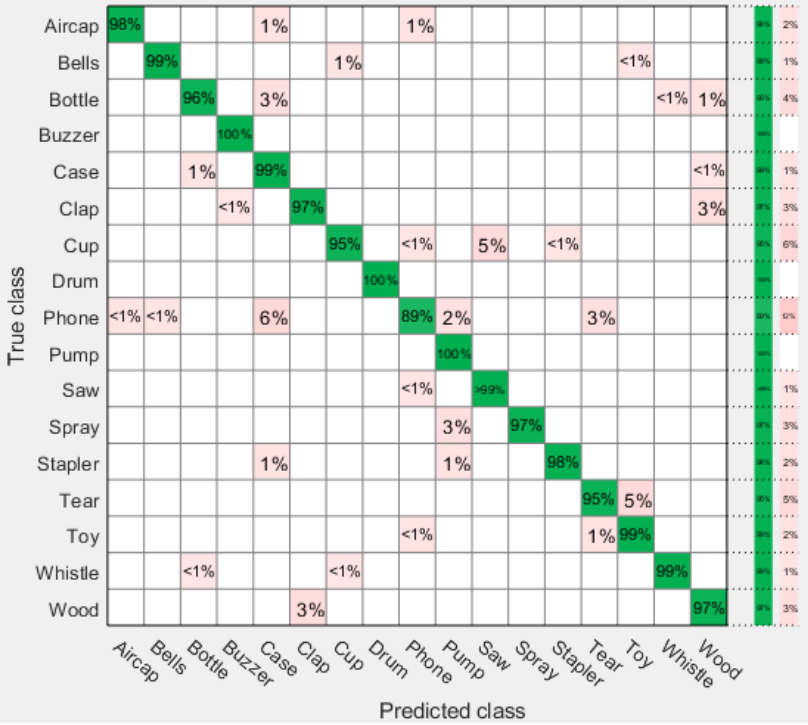
Figure 4: Acoustic scene classification evaluation over